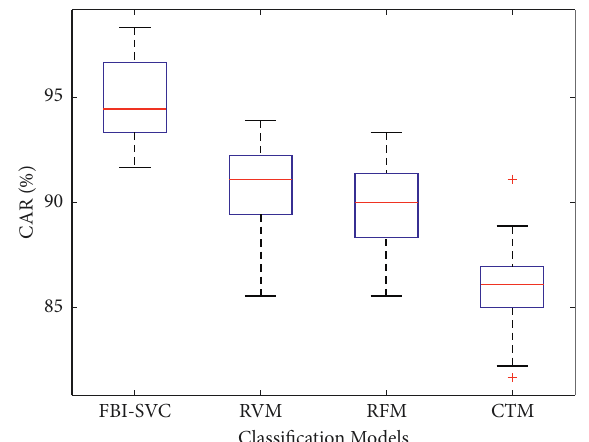
Figure 13: Box plot of CAR values obtained from the employed machine learning models.